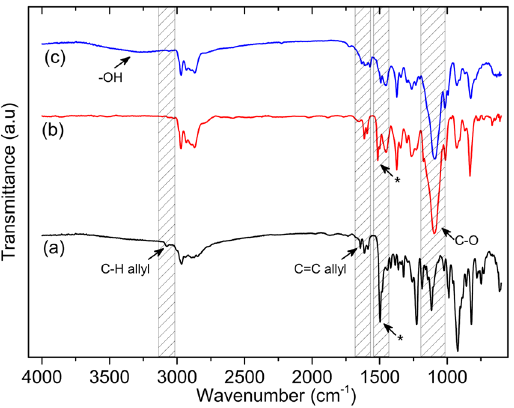
Figure 3. FTIR spectra of B-al ( a ), PPOB ( b ), PPOB 40 -B-al 40 -S 20 ( c ). ( * tri-substituted benzene ring of benzoxazine).